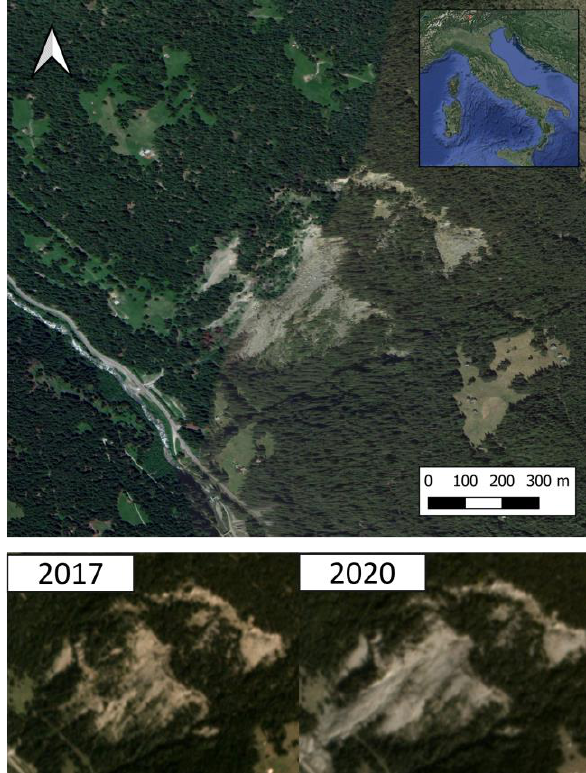
Figure 2. The location of Ruinon landslide. The landslide in 2017 and 2020 ( source: Planet,2017; basemap - Google Satelite through QuickMapServices QGIS plugin, Map data © Google